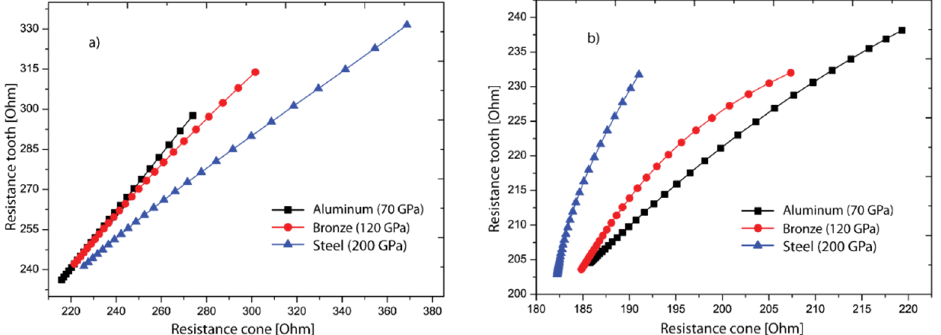
Figure 9. Relation between electrical resistance signals obtained with cone and premolar as coupling interfaces: ( a ) 9.3–9.7 kHz. ( b ) 11.1–11.5 kHz.